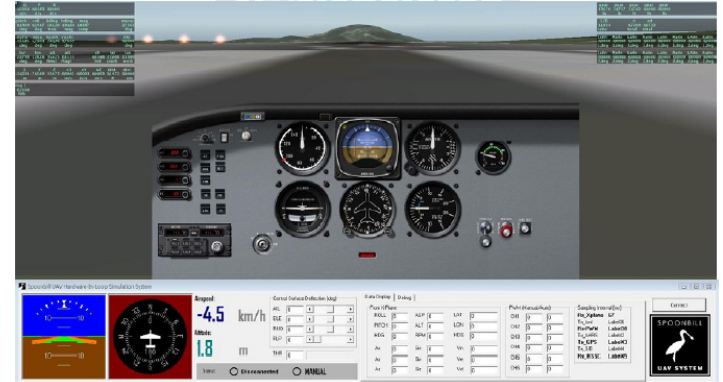
Figure 12. Communication between X ‐ Plane and onboard computer with the help of GUI program. GUI, graphic user interface.